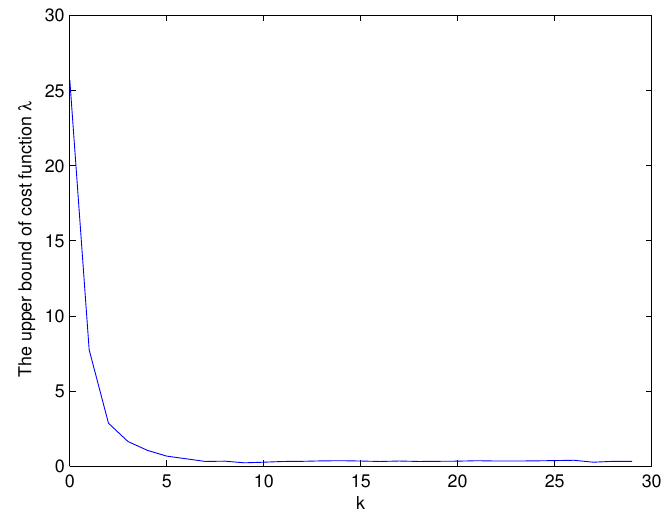
Figure 7. The curve for the upper bound of the cost